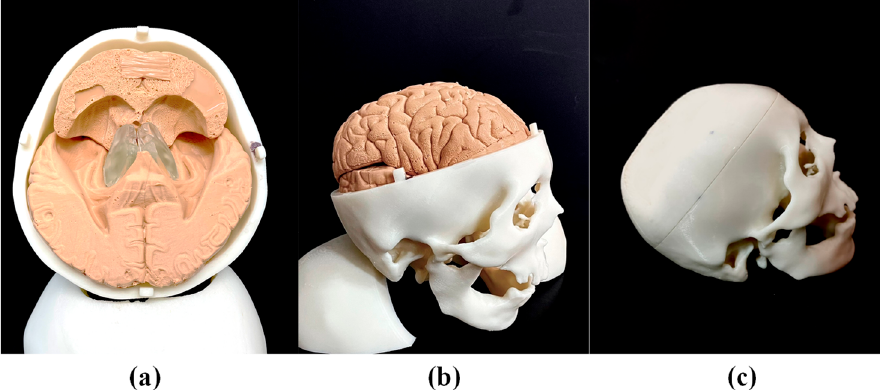
Figure 4. ( a ) Top-view image of simulator prior to assembly of the top skull, frontal lobe, and pari- etal lobe; ( b ) side-view image of simulator prior to placement of the top skull; ( c ) entire simulator ready for practicing surgical techniques.